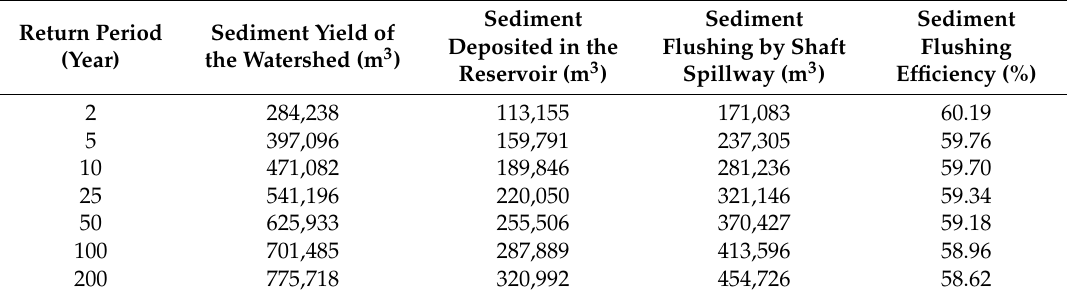
Table 2. Empty flushing efficiency in two-day storms under different return